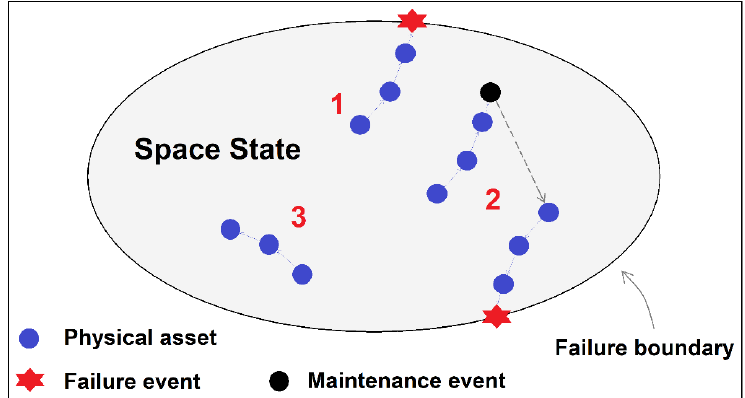
Figure 1. Maintenance Space State: (1) Asset life cycle without maintenance events, (2) Failure event with maintenance events, and (3) No failure events. Own elaboration inspired from [25].